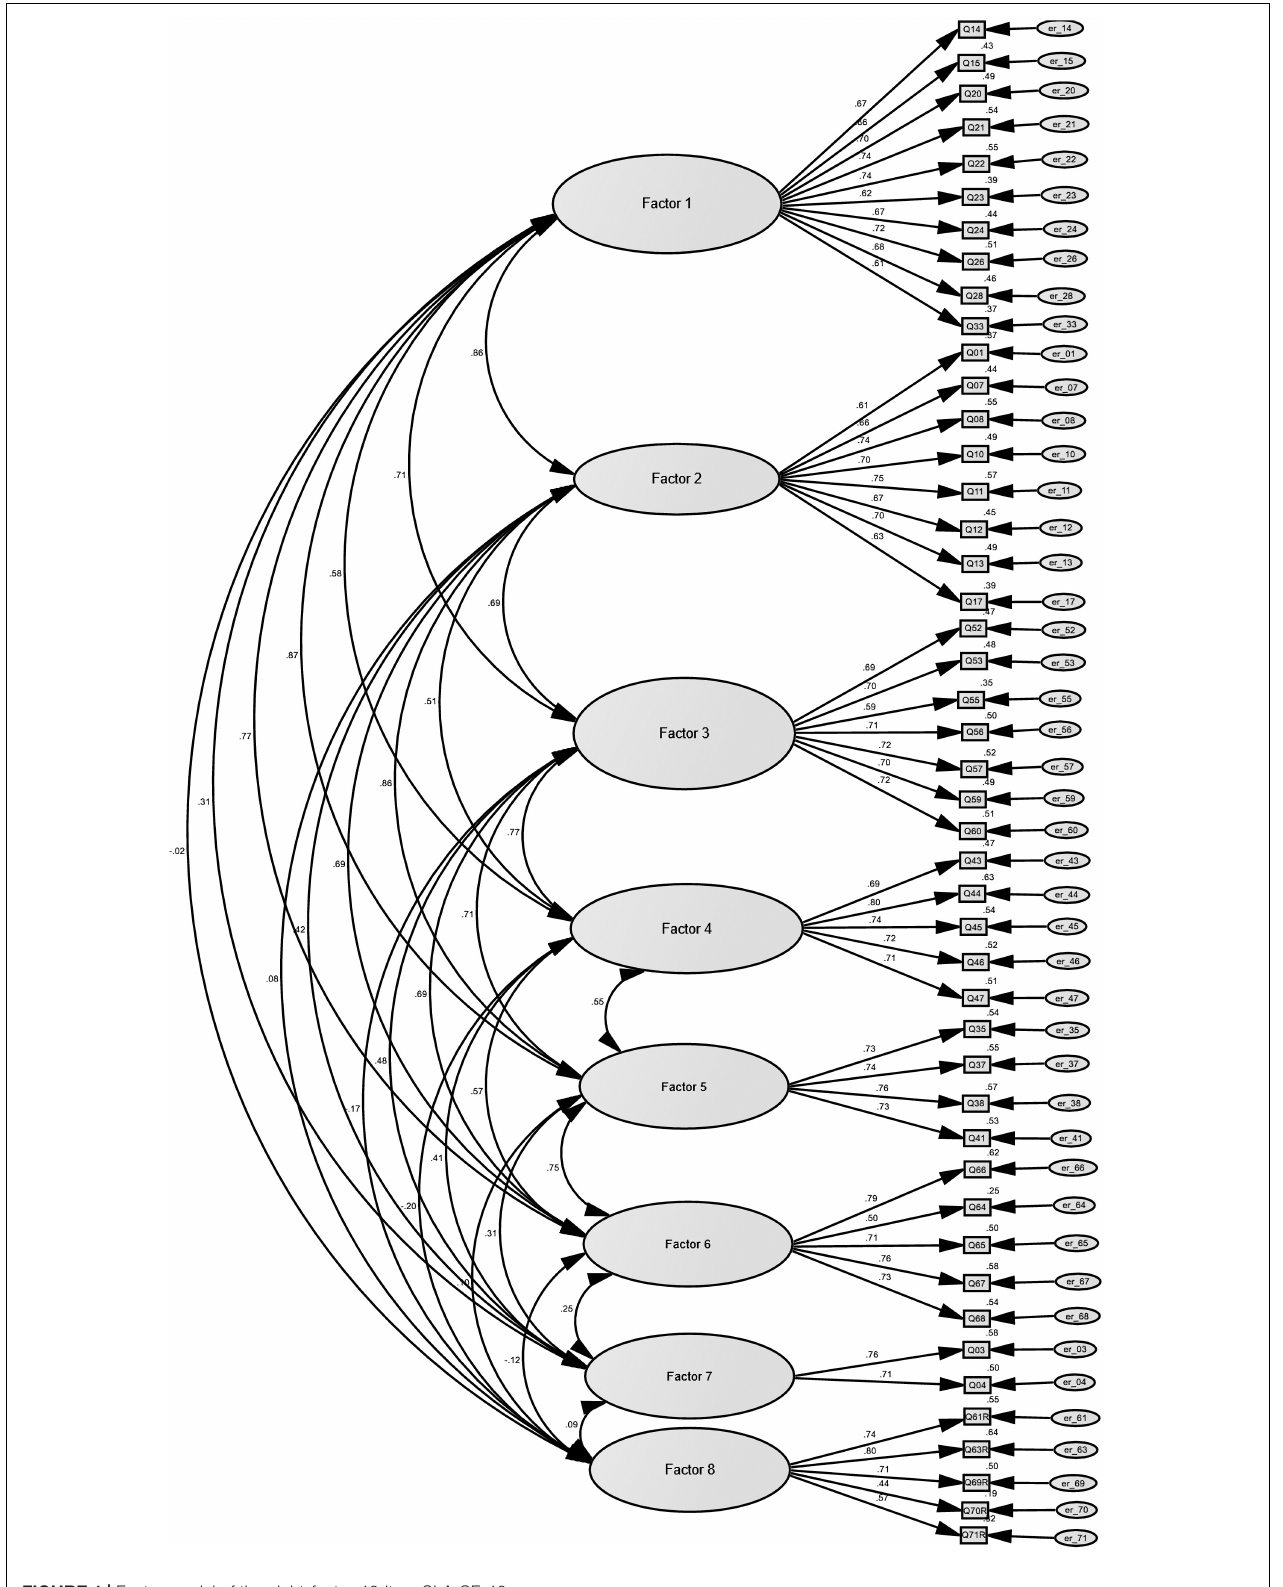
FIGURE 1 | Factor model of the eight-factor 46-item